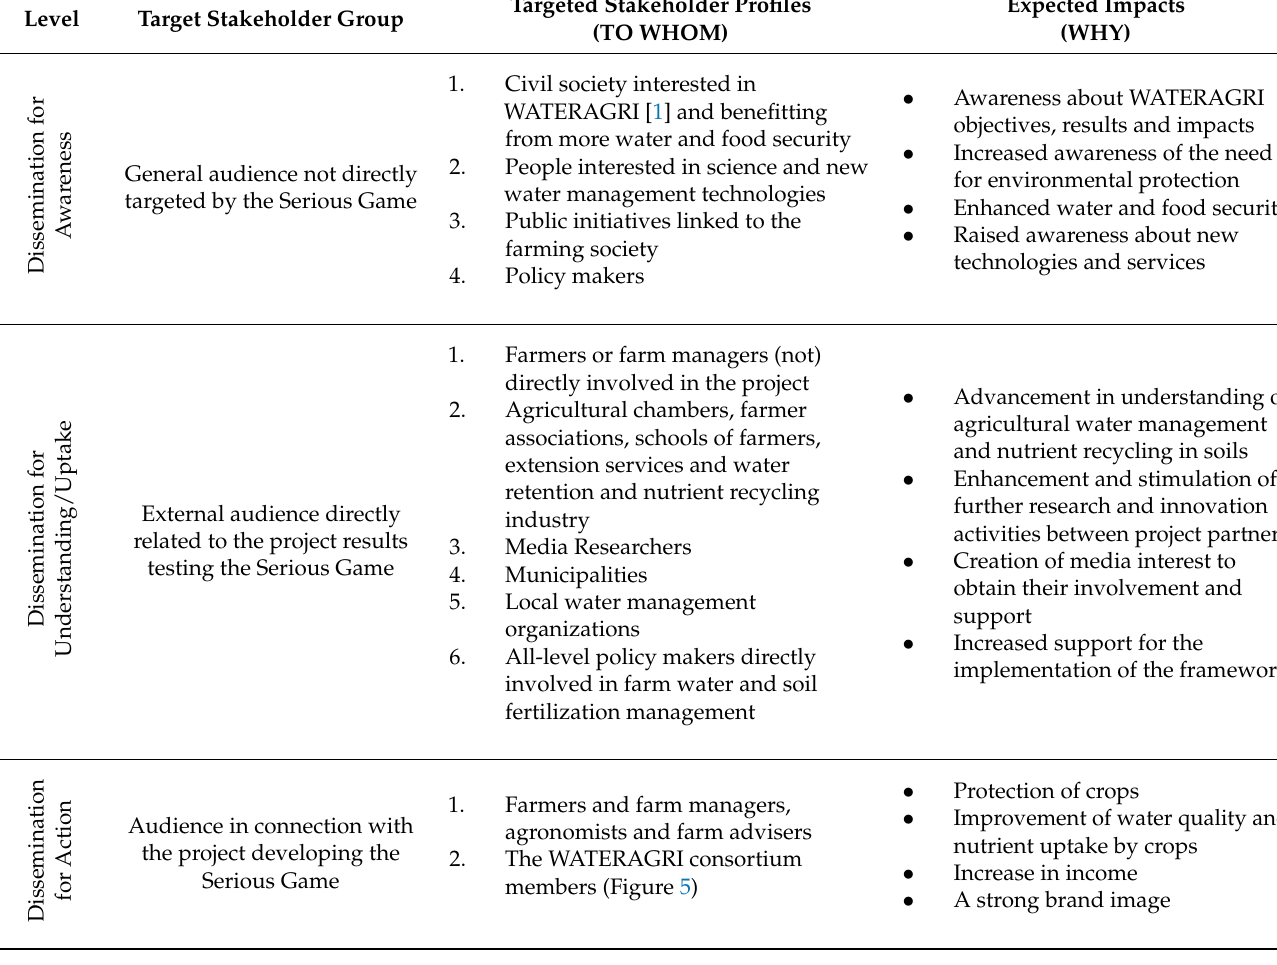
Table 2. Overview of the levels of WATERAGRI dissemination strategy impacts on the main stake- holder groups and their relationship to the Serious Game (A7; Table